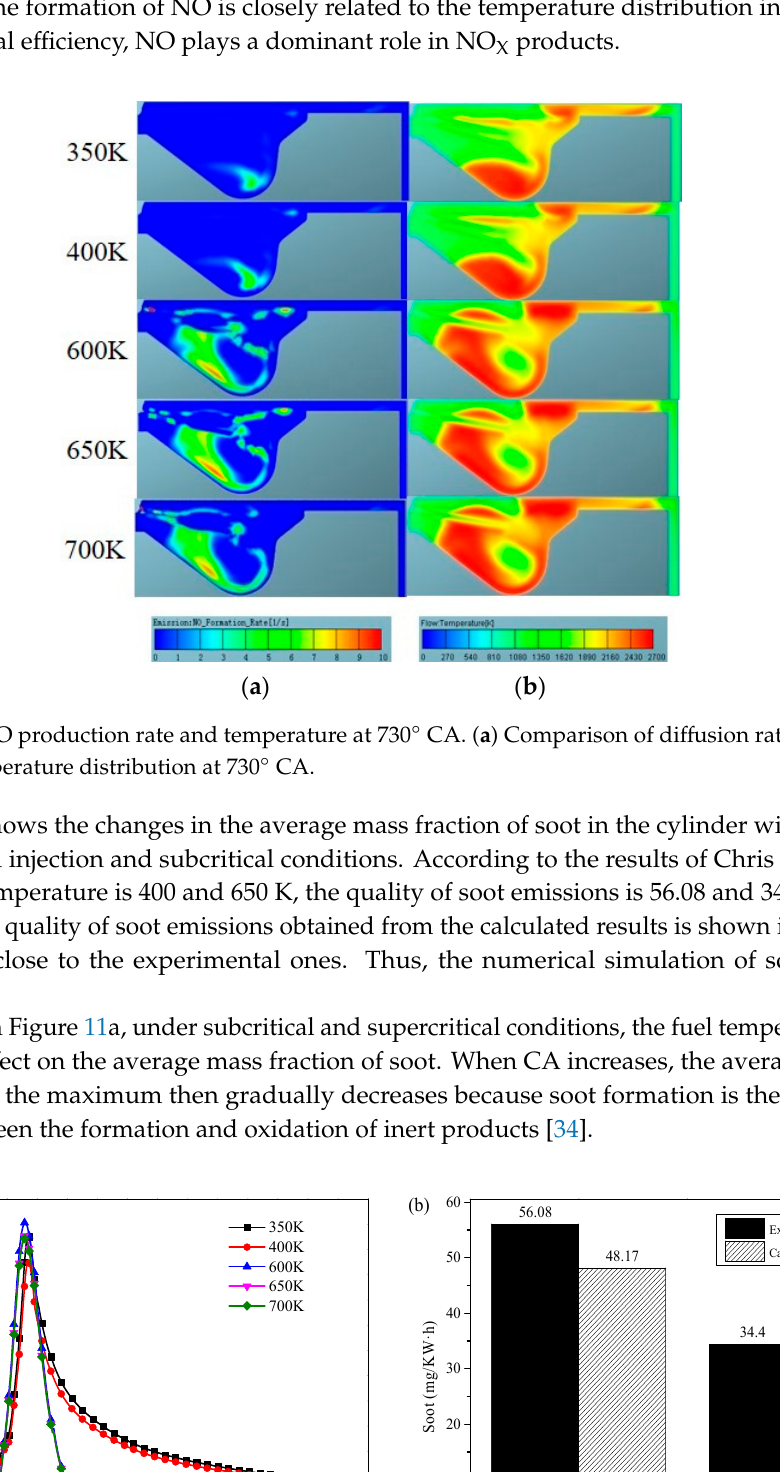
Figure 11. (a) Change curve of the mass fraction of soot; (b) comparison of soot emission.